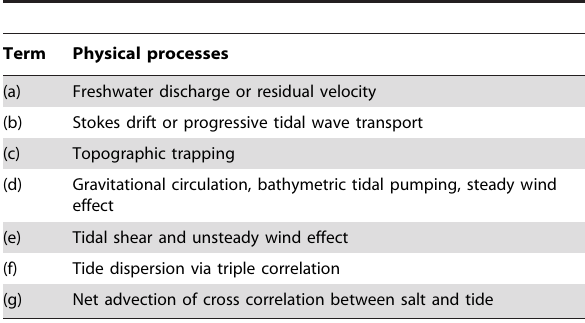
Table 2. Physical processes related with the terms of equation